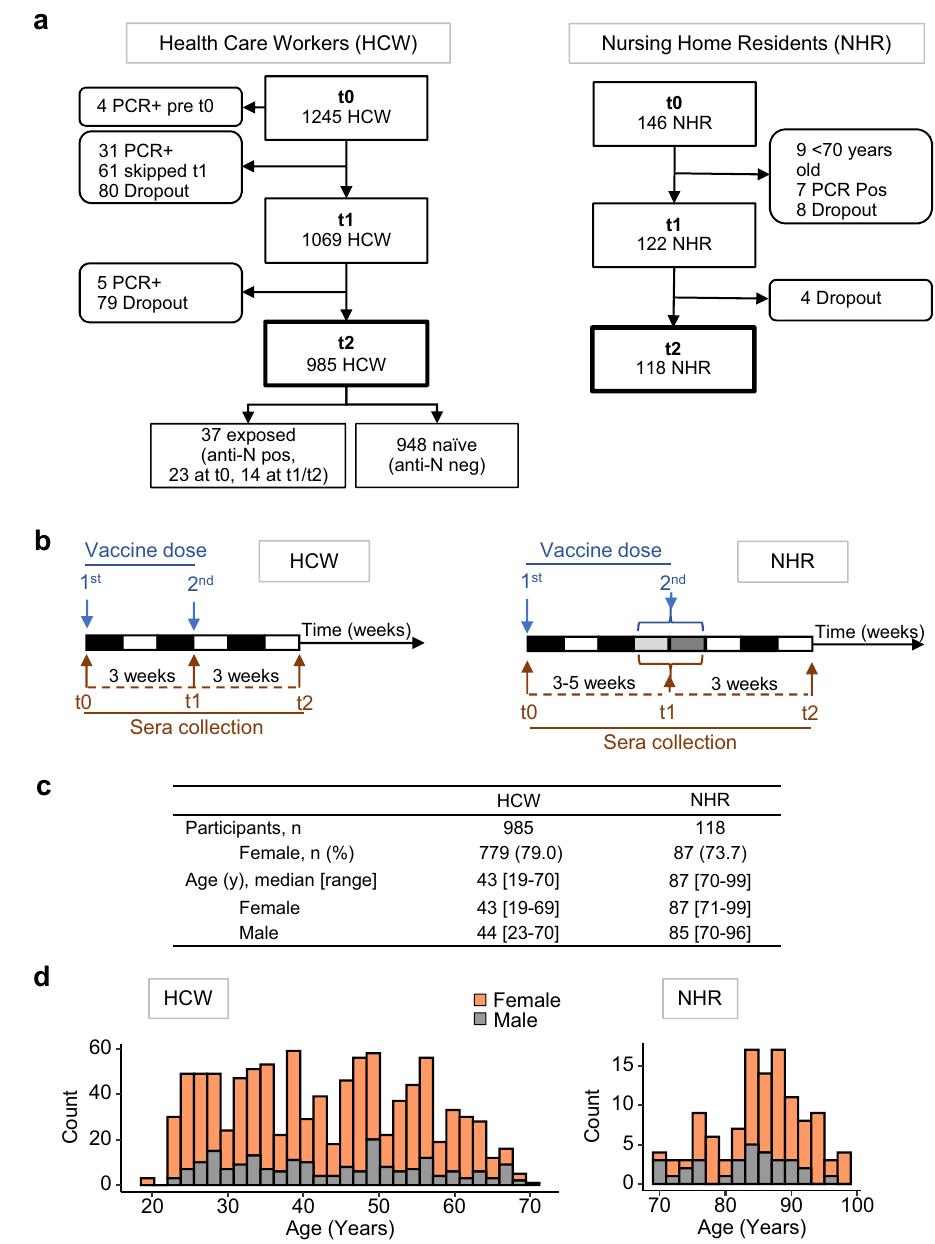
Fig. 1 Cohort speci fi cation. Hospital healthcare workers (HCW) and nursing home residents (NHR) donated blood samples before vaccination with BNT162b2 RNA (t0), 3 – 5 weeks after the 1 st dose (t1) and 3 weeks after the 2 nd dose (t2). a Enrollment and funnelling of participants,